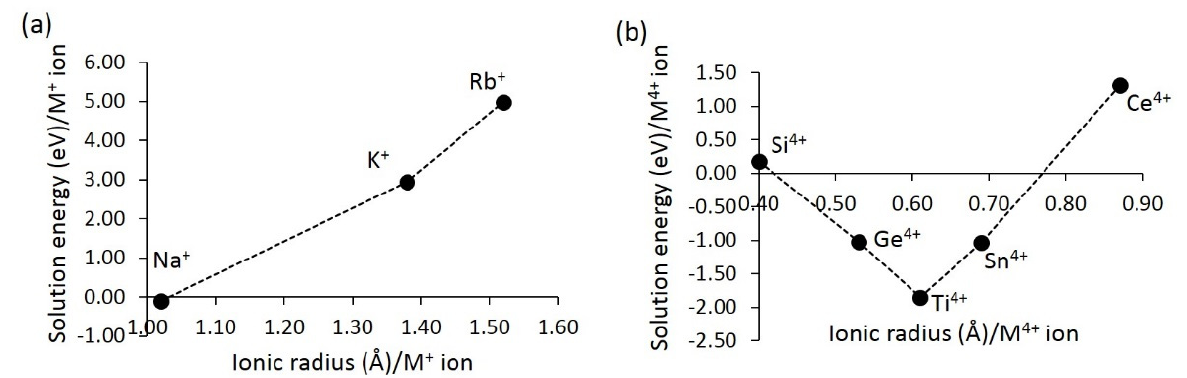
Figure 4. Solution energies calculated for ( a ) M 2 O (M = Na, K and Rb) and ( b ) MO 2 (M = Si, Ge, Ti, Sn and Ce).